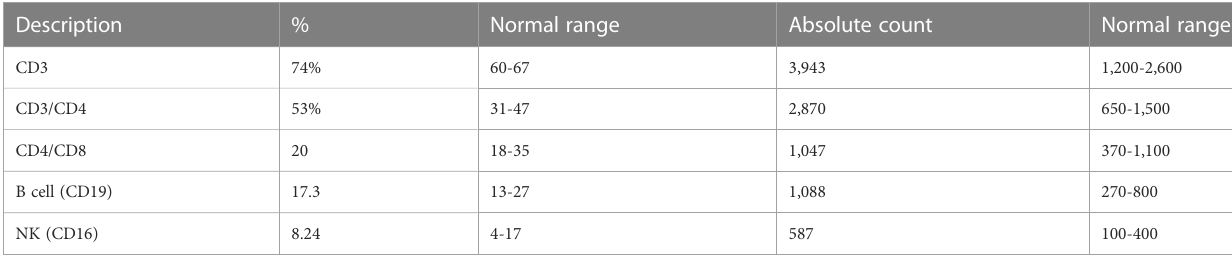
TABLE 2 Patient lymphocyte subset fl ow cytometry results.